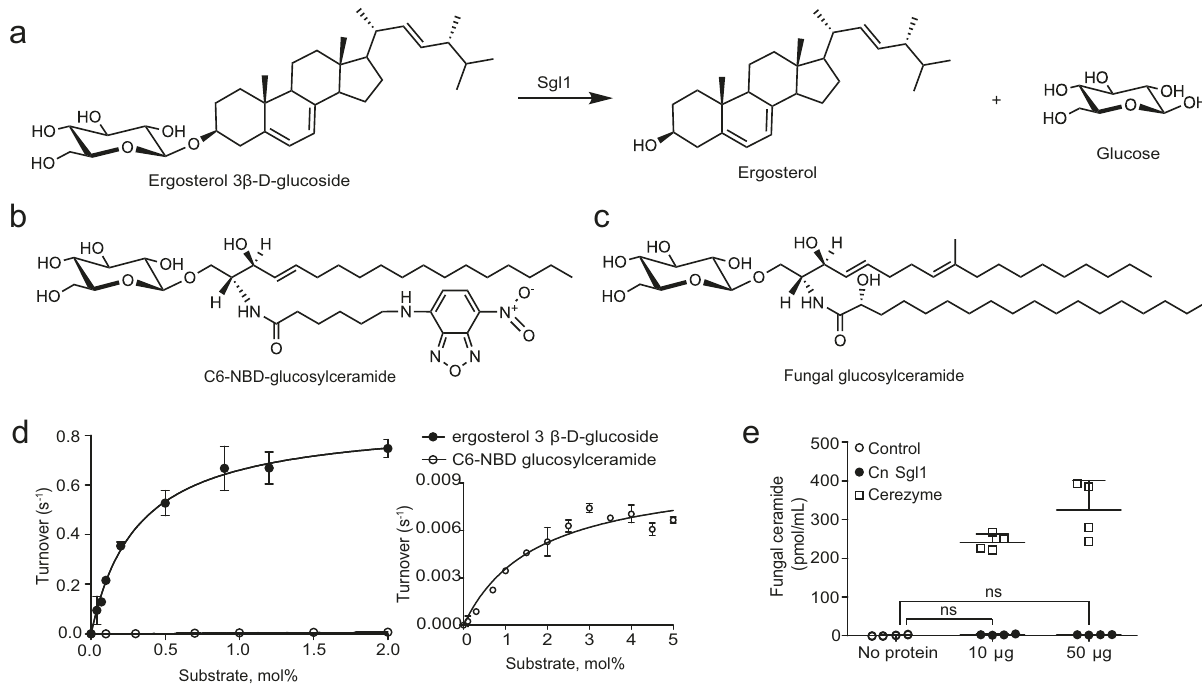
Fig. 1 Sgl1 is speci fi c for ergosterol 3 β - D -glucoside. a Ergosterol 3 β - D -glucoside (erg-glc) hydrolysis by Sgl1 yields ergosterol and glucose. b Chemical structures of C6-NBD-glucosylceramide (C6-NBD-GlcCer) and c fungal GlcCer. d Kinetic analysis of erg-glc (black circles) and C6-NBD-GlcCer hydrolysis (open circles) by Sgl1. Sgl1 readily hydrolyzed erg-glc while C6-NBD-glcCer was a relatively poor substrate. Data represent the mean ± SD for n = 2 independent experiments. e Comparison of Cerezyme and C. neoformans (Cn) Sgl1 activity against fungal long-chain glucosylceramide. There was no signi fi cant difference between the control with no enzyme and samples with Cn Sgl1 at 10 or 50 µ g. Statistical analysis by one-way ANOVA, Dunnett ’ s multiple comparison test. Data represent the mean ± SD of n = 4 independent experiments. Source data are provided as a Source Data fi